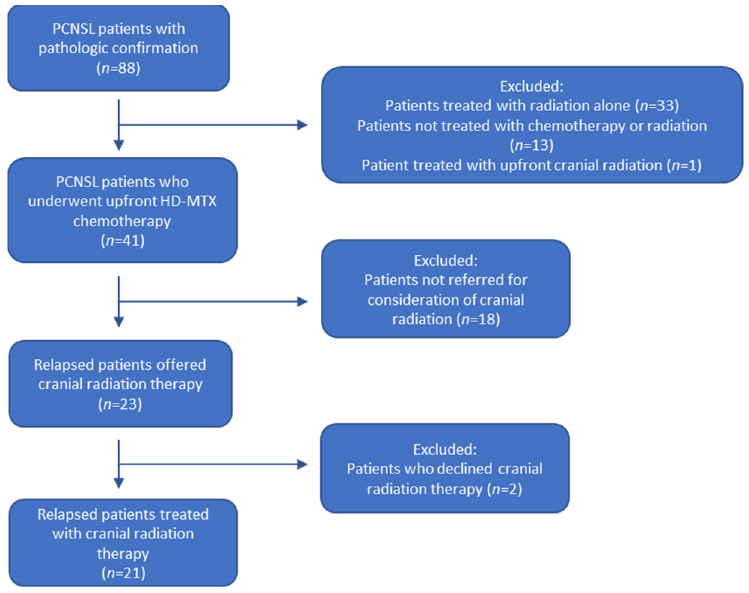
Figure 1. Flow diagram for patient selection. PCNSL: primary central nervous system lymphoma. HD-MTX: High-dose methotrexate.